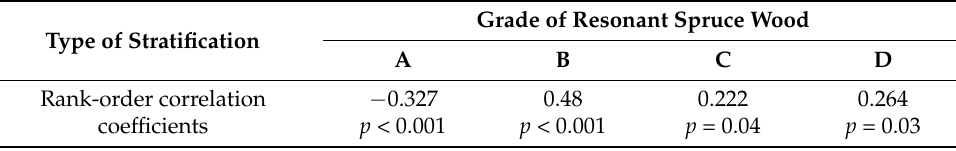
Table 4. Variation in the LWP according to the annual ring width stratified by the quality class of the sample (legend: significance p